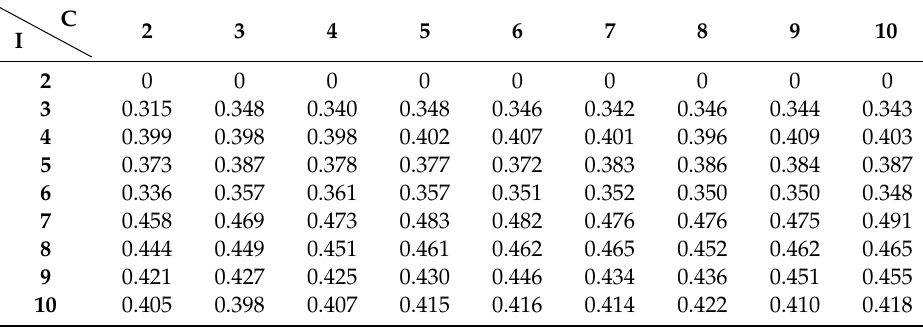
Table 4. CCS prediction results for interval-based IGM (Case 2) using testing